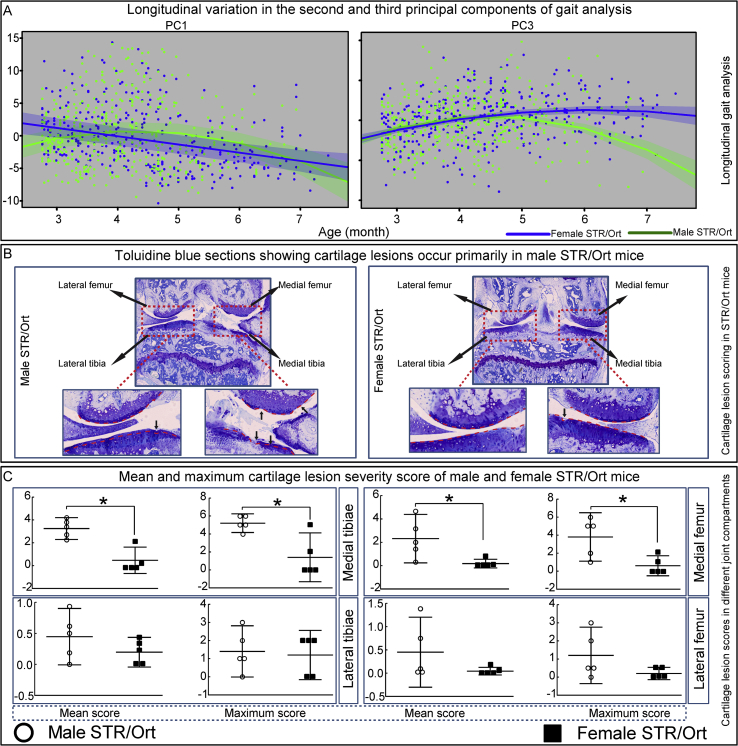
Sexually dimorphic Osteoarthritis (OA) development and progression is linked to development of longitudinal gait asymmetry and indices of spontaneous OA in STR/Ort mice. (A) Linear graphs depict principal component distribution and differences in gait patterns of male (green) and female (blue) STR/Ort mice for PC1 and PC3 longitudinally; left/right differences were negated by referring to these as max/min ensuring that both L/R and R/L asymmetries will be additive. (B) Cartilage lesion scores in different joint compartments of male and female STR/Ort mice. Mean and maximum with 95% confidence interval (CI) lesion severity scores in each compartment of male (circle) and female (square) STR/Ort joints. (C) Lower and higher power toluidine blue stained sections of joints from male and female STR/Ort mice showing locations of naturally occurring lesions in the articular cartilage (AC) of the lateral femur compartment of the tibiofemoral joint. For gait analysis group sizes were n = 31 and n = 24 for male and female STR/Ort mice, respectively. For cartilage lesion scoring group sizes were n = 5 for male and female STR/Ort mice.